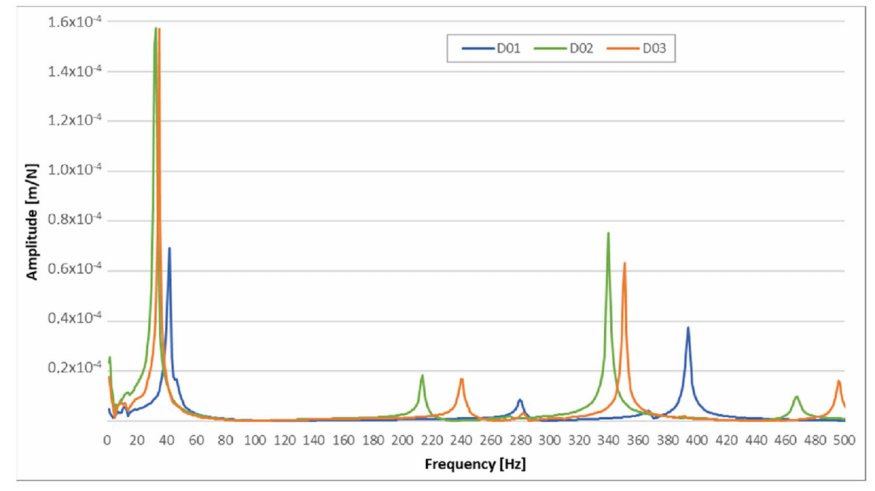
Figure 11. FRF measurement of composite samples: CO—Carbon, CL—hybrid carbon–flax, S—glass, L—Flax.